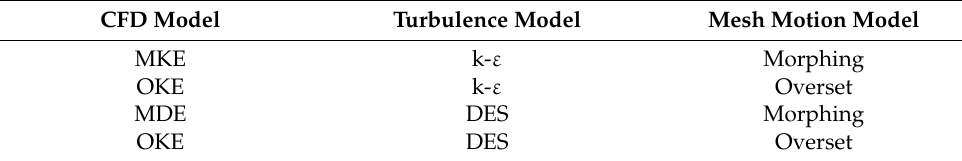
Table 2. Different CFD models used to solve the steady planing